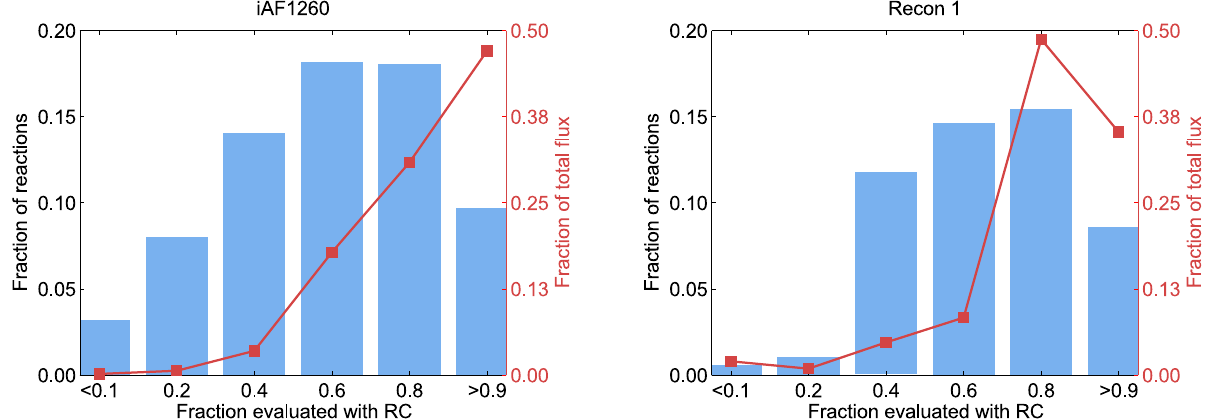
Figure 5. Distribution of the fractions of reaction vectors (black) in iAF1260 ( E. coli ) and Recon 1 (human), that were in the range of S , and were thus evaluated with reactant contribution (RC). For a reaction x , this fraction was calculated as E x R E 2 = E x E 2 . Passive and facilitated diffusion reactions, where the reactants undergo no chemical changes, are not included in the figure. 9.4% of all evaluated reactions in iAF1260 were fully evaluated using only reactant contributions. These reactions carried approximately half of the total flux (red) in 312 predicted flux distributions. The 8.3% of evaluated reactions in Recon 1 that were fully evaluated with reactant contributions, carried close to a third of the total flux in 97 predicted flux distributions.